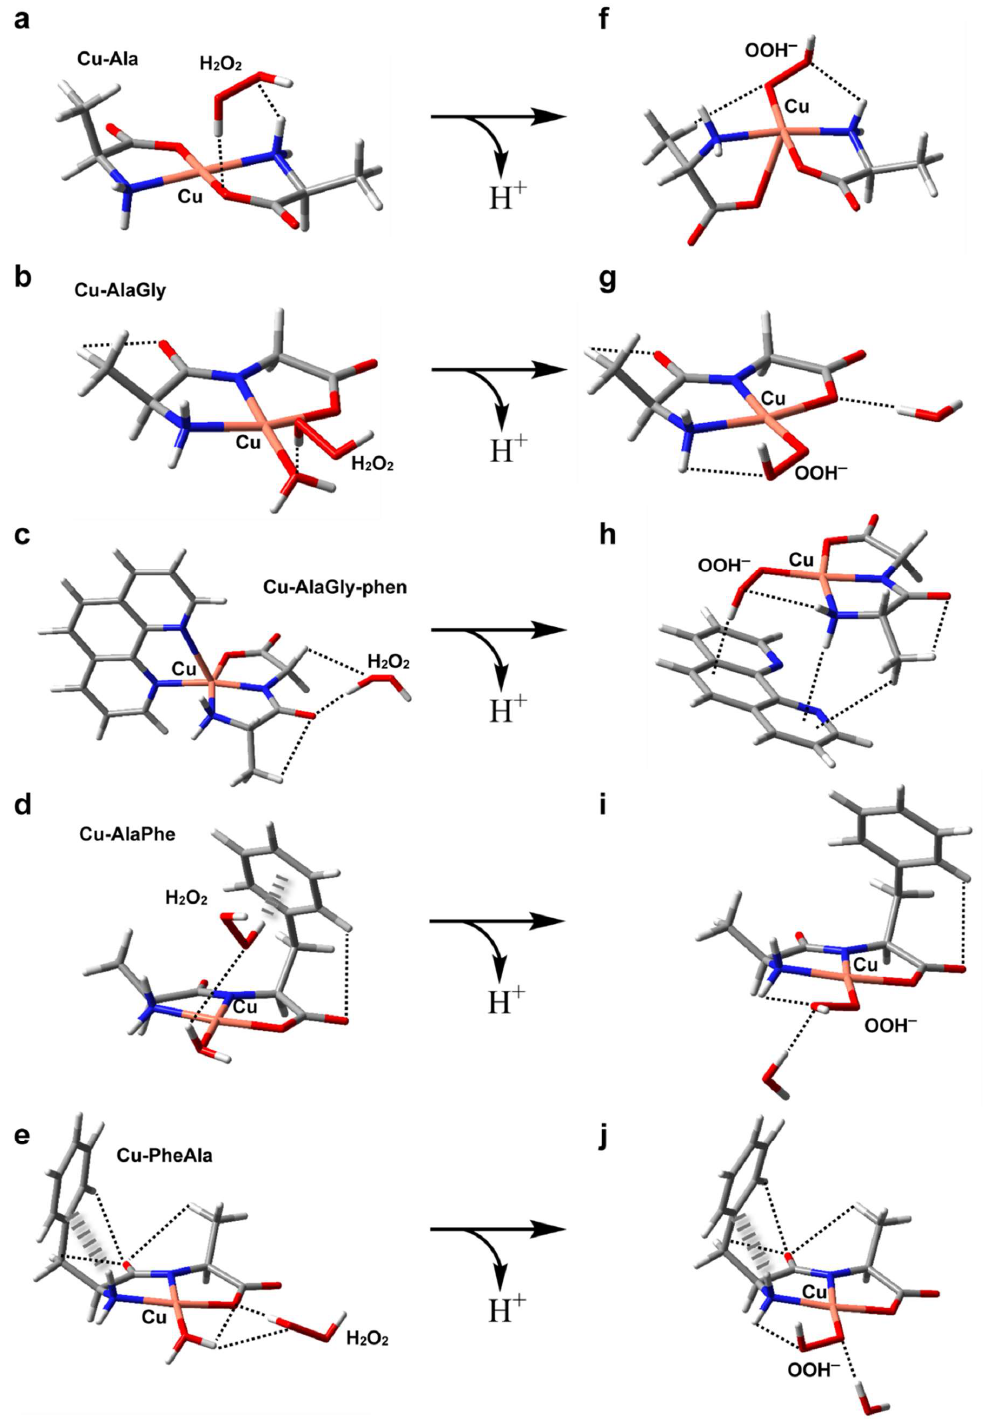
Figure 6. DFT-optimized geometries in aqueous solution of the adducts formed by hydrogen peroxide with Cu–Ala ( a ), Cu–AlaGly ( b ), Cu–AlaGly–phen ( c ), Cu–AlaPhe ( d ) and Cu–PheAla) ( e ). In ( f – j ), the optimized structures of the corresponding OOH − complexes are depicted, with the noncovalent intramolecular interactions represented as dashed (H-bonds) or hatched (H-π interactions) lines. Atom color code: C (gray), H (white), N (blue), O (red), Cu (pink).